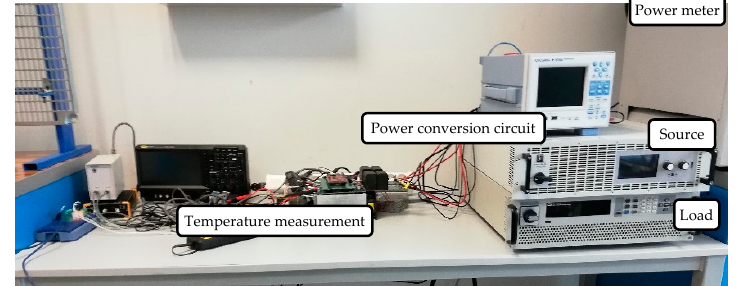
Figure 14. The built set-up for the experimental tests.